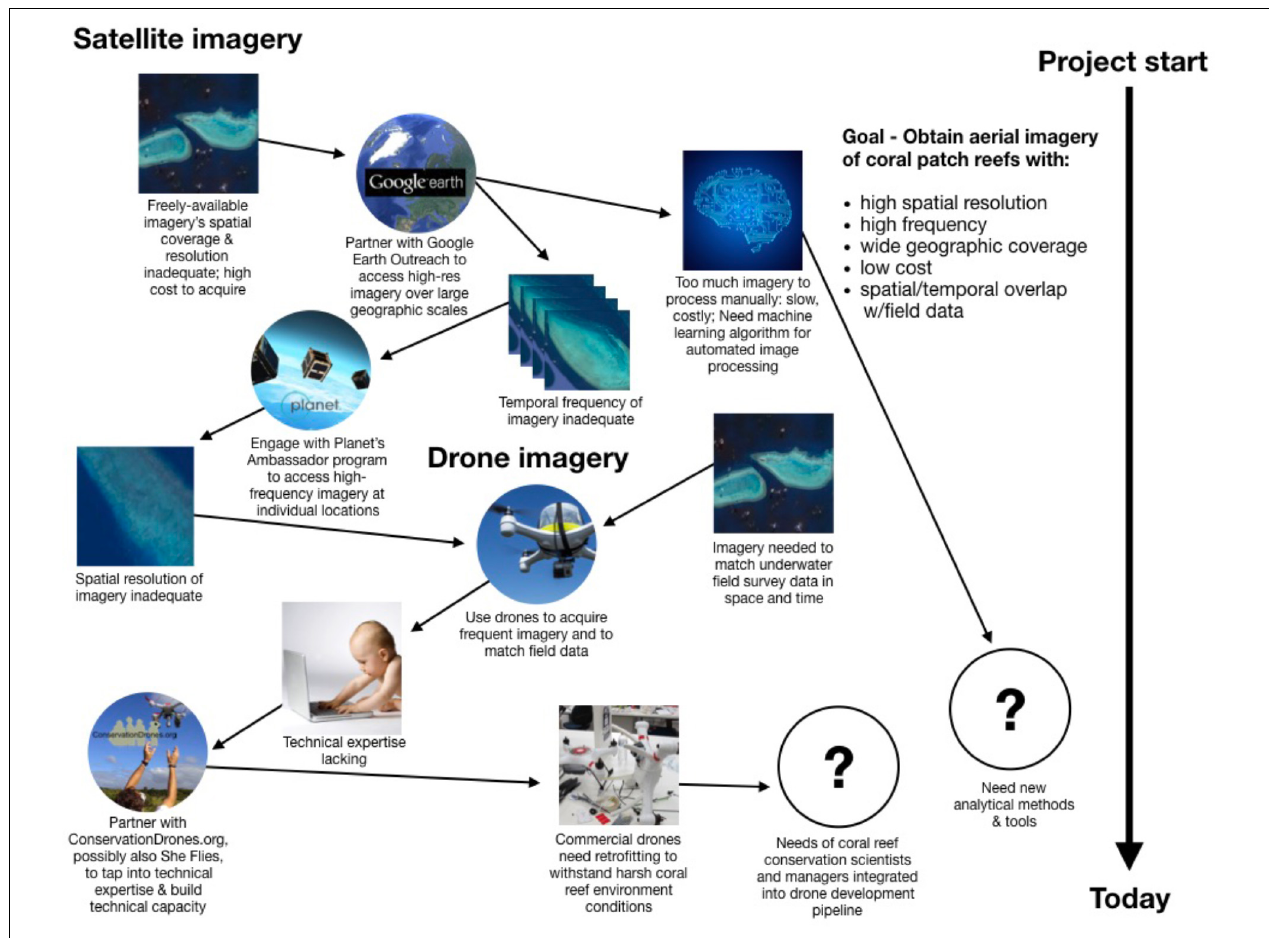
FIGURE 2 | Diagram of one project’s journey integrating emerging technologies into coral reef conservation science encompassing barriers (squares) and strategies (circles) to achieve its goals. The field component of this project took place at Heron Island on Australia’s southern Great Barrier Reef. The aim of the project was to determine the ecological mechanisms responsible for the formation of landscape-scale vegetation patterns surrounding coral reefs known as reef “halos” (Madin et al., 2019). In order to achieve this aim, it was necessary to obtain and process satellite imagery with specific characteristics. Arrows indicate the non-linear progression of the project through various barriers and strategies implemented for overcoming these barriers. Image credits: Barbara Breen/NZ Herald; Tim Calver/TNC; www.reseiwe.com; DigitalGlobe;